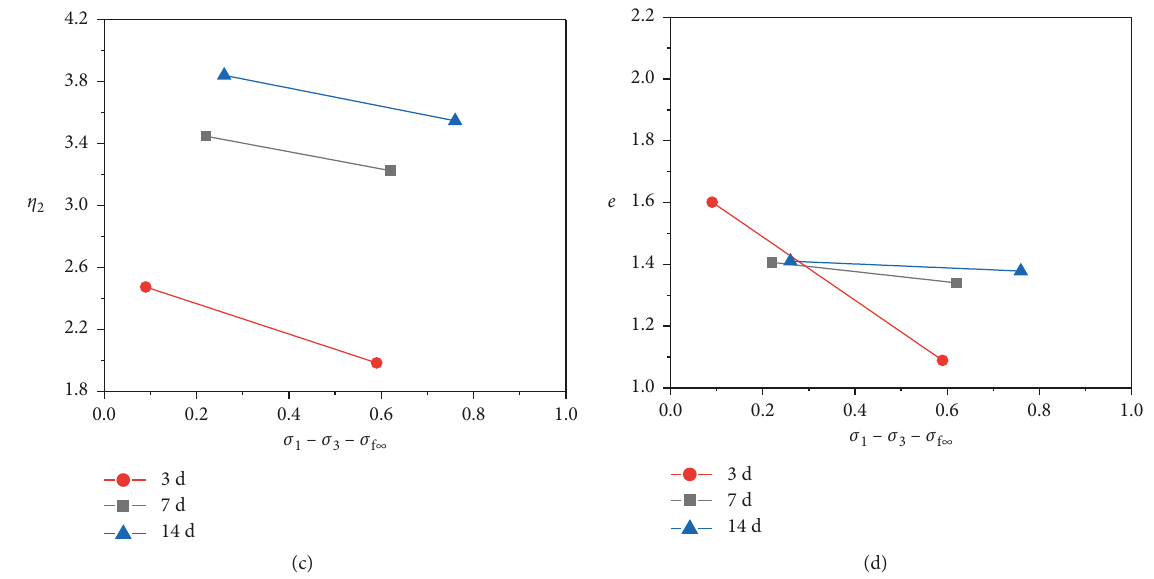
Figure 16: The variation in creep parameters ( σ